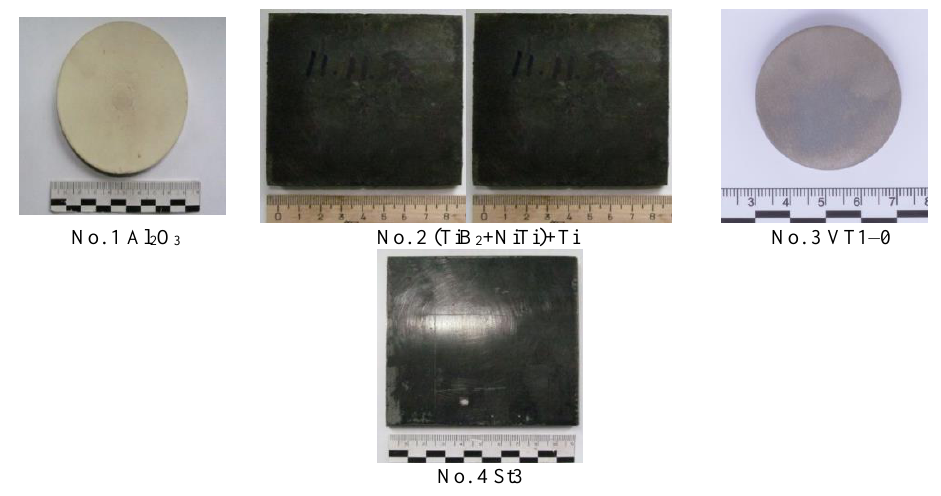
Fig. 3. The samples of tested